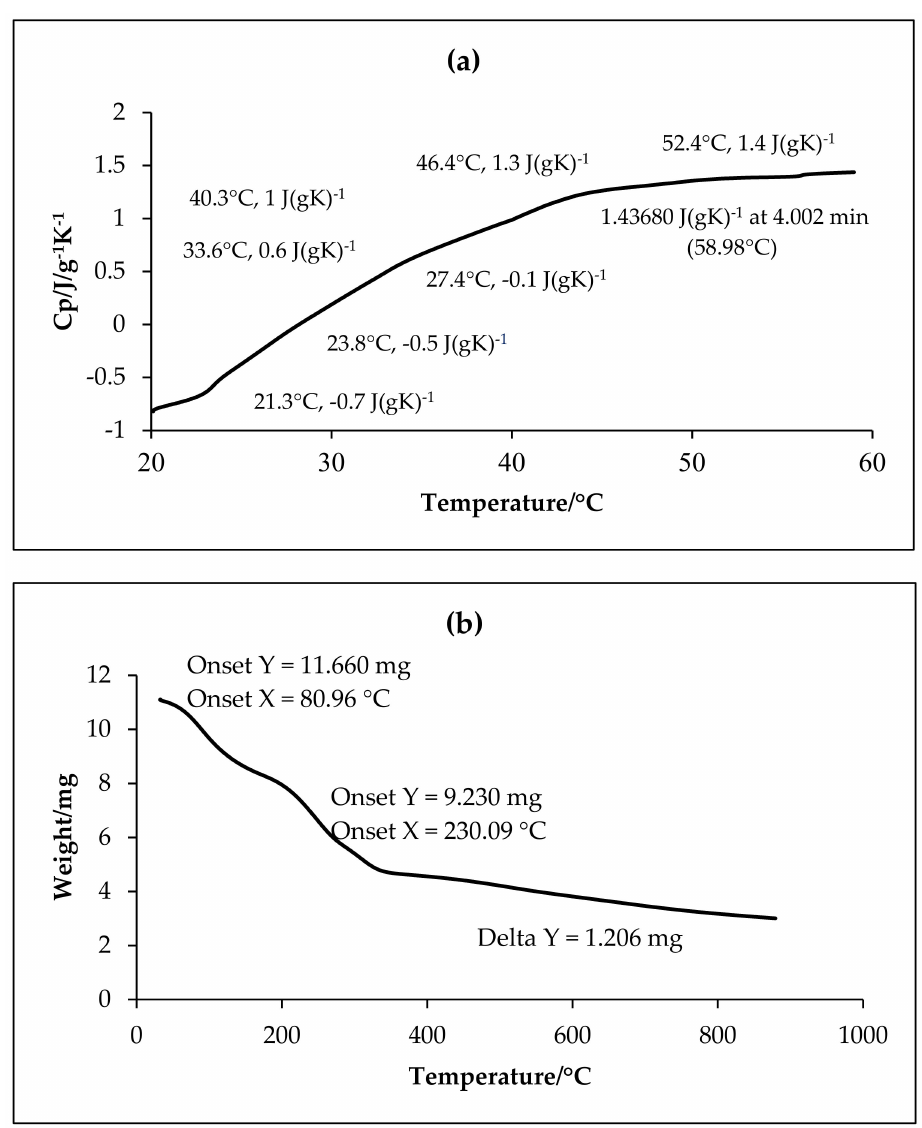
Figure 4. Thermal properties of the functionalized graphene nanoplatelets (f-GNPs) by differential scanning calorimetry (DSC) ( a ) and thermogravimetric analysis (TGA) ( b